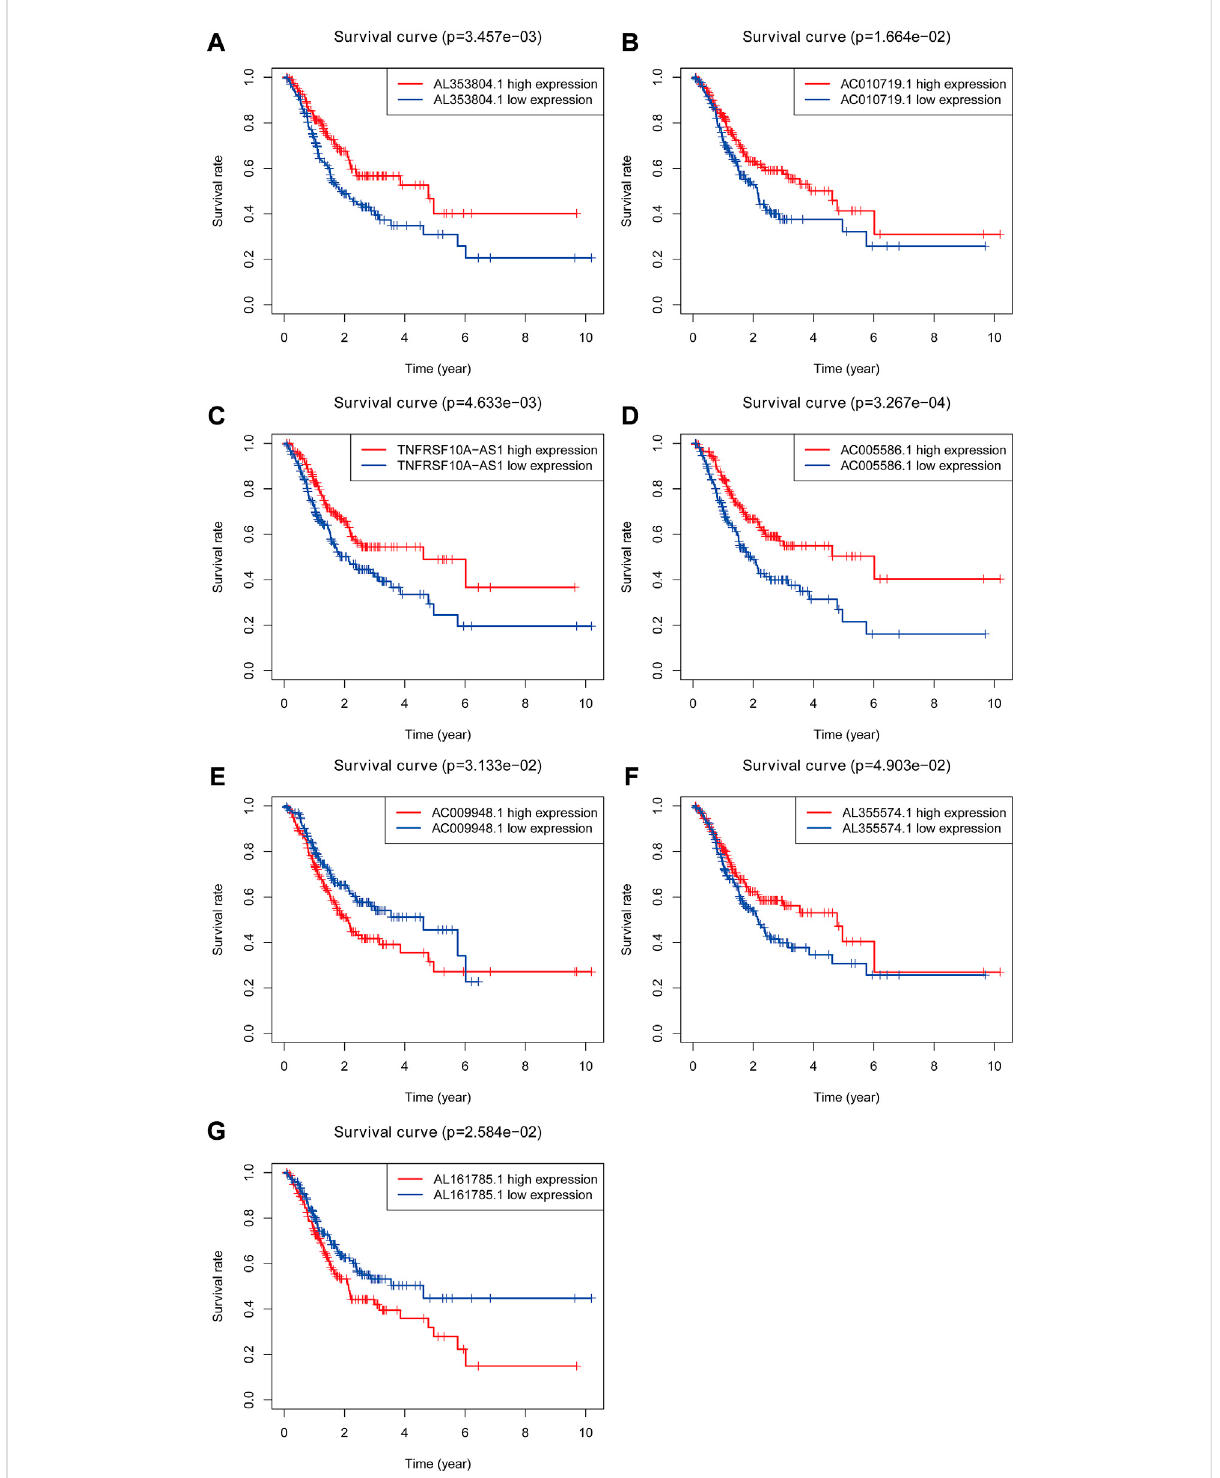
FIGURE 3 TheKaplan-MeierSurvivalcurveofsevenprognosticglycolysis-relatedlncRNAs.Twoglycolysis-relatedlncRNAs(AC009948.1andAL161785.1) were independent unfavorable factors. Five lncRNAs (AL353804.1, AC010719.1, TNFRSF10A-AS1, AC005586.1 and AL355574.1) were independent bene fi cial factors for